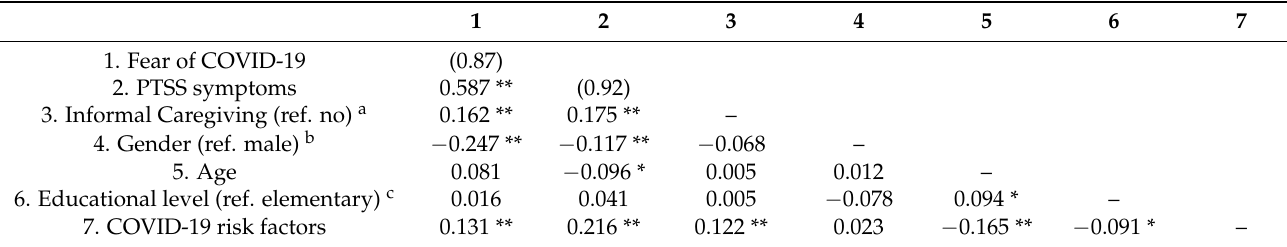
Table 2. Bivariate correlations of study